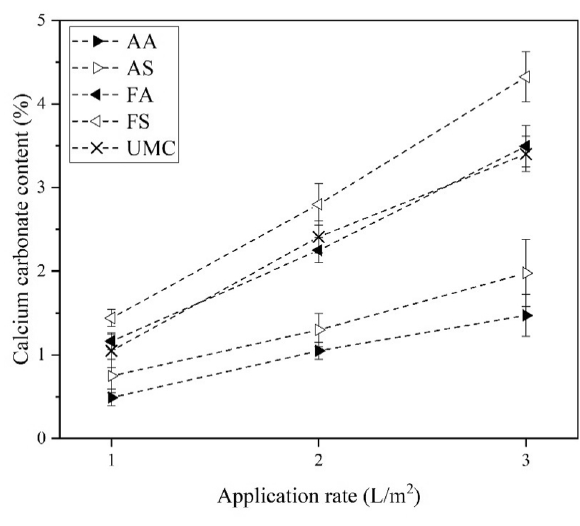
Figure 12. Calcium carbonate content versus application